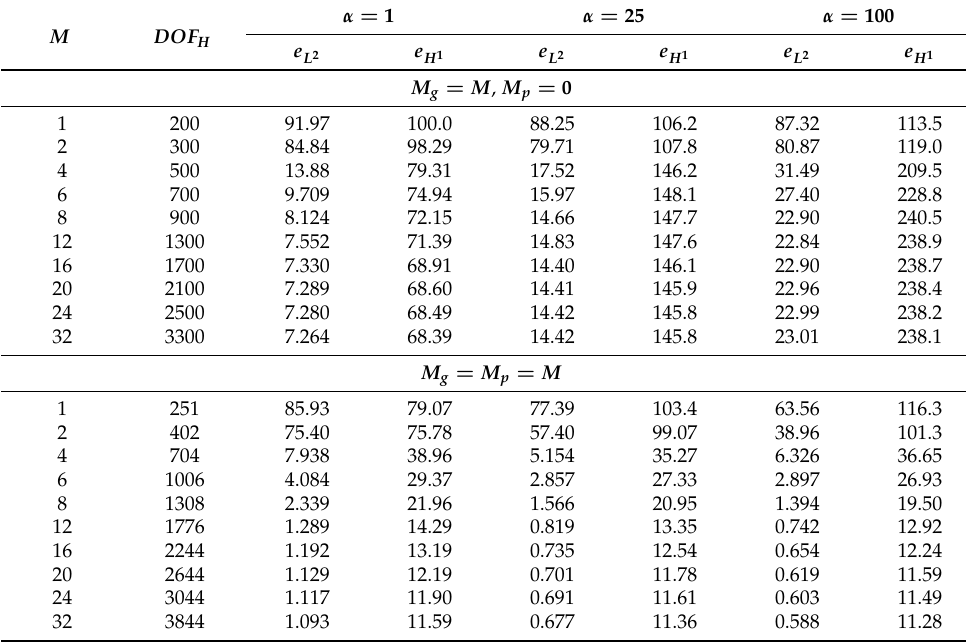
Table A2. Parabolic problem with α = 1,25, and 100. Case 2 (non-homogeneous boundary condi- tions). Relative L 2 and H 1 error in %. DOF h = 85,230.